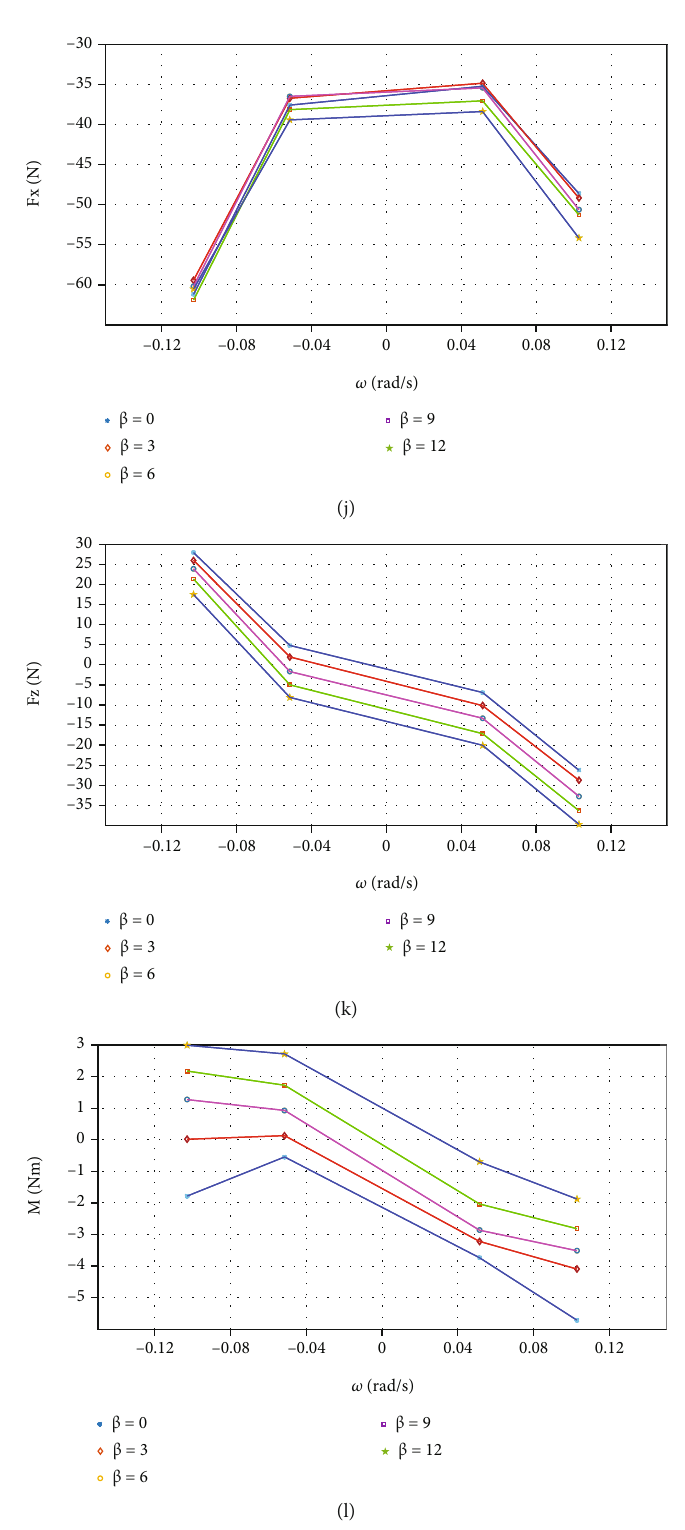
Figure 8: Relationship between angular velocity and forces and moments in the rotating arm test: (a) between Fx and ω ( β = 0 ) in the horizontal plane; (b) between Fy and ω ( β = 0 ); (c) between N and ω ( β = 0 ); (d) between Fx and ω ( α = 0 ) in the horizontal plane; (e) between Fy and ω ( α = 0 ); (f) between N and ω ( α = 0 ); (g) between Fx and ω ( β = 0 ) in the vertical plane; (h) between Fz and ω ( β = 0 ); (i) between M and ω ( β = 0 ); (j) between Fx and ω ( α = 0 ) in the vertical plane; (k) between Fz and ω ( α =0); (l) between M and ω ( α = 0